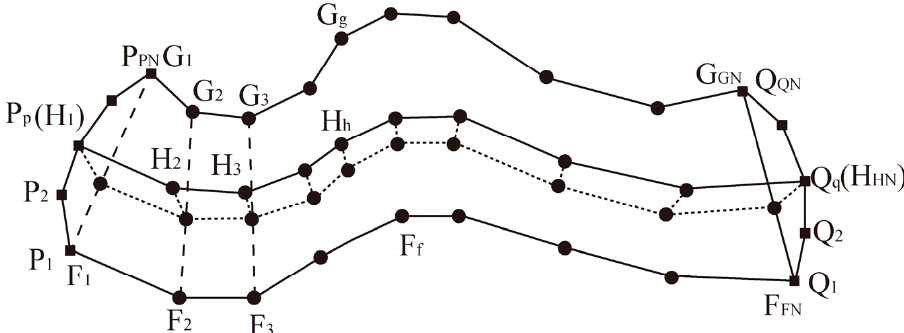
Figure 12. Schematic diagram of the three-edge type for interpolating transition curves. This study takes the C4 region as an example to show the division outcome and the interpolation results of the transition curves and mesh surface (Figure 13).